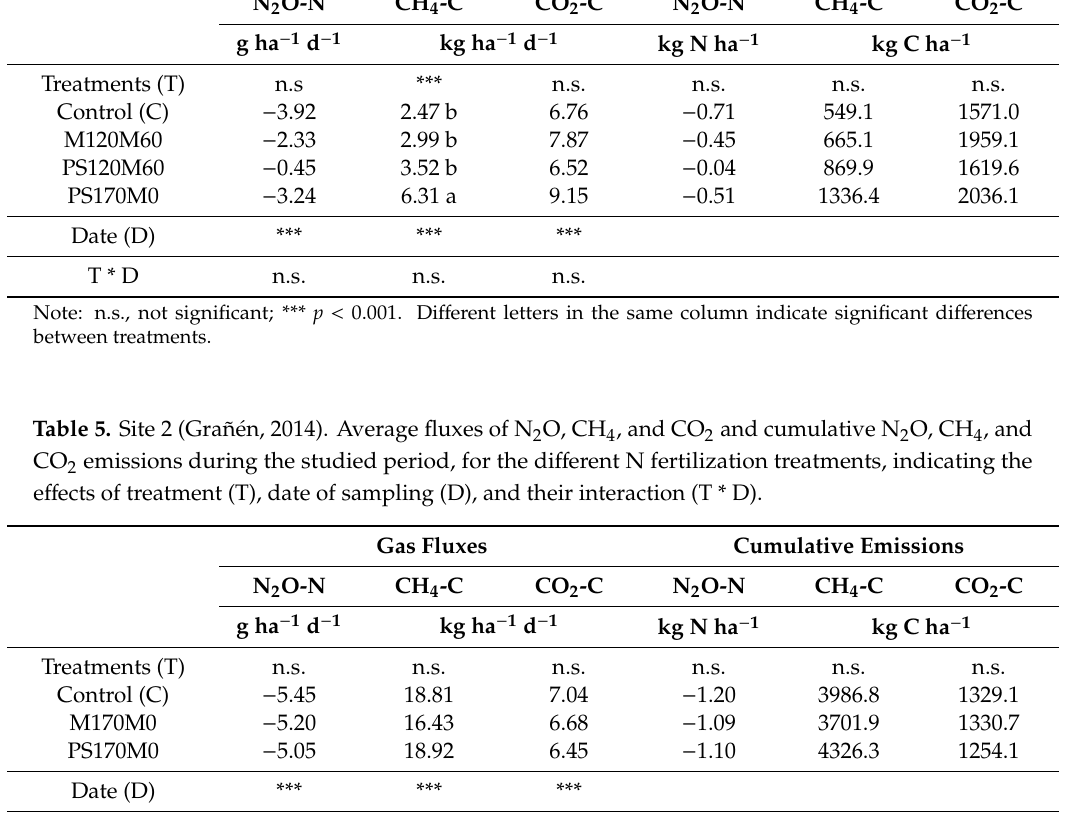
Table 4. Site 1 (Villanueva de Sigena, 2013). Average fluxes of N 2 O, CH 4 , and CO 2 and cumulative N 2 O, CH 4 , and CO 2 emissions during the studied period, for the di ff erent N fertilization treatments, indicating the e ff ects of treatment (T), date of sampling (D), and their interaction (T × D). Gas Fluxes